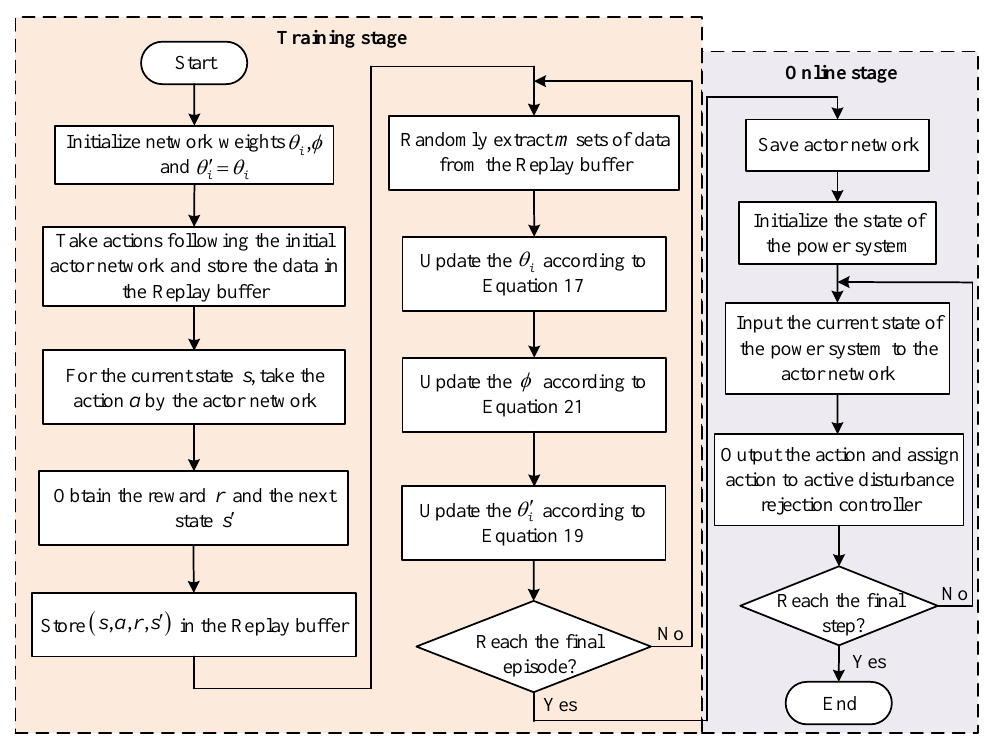
Figure 4. Flowchart of LADRC parameter optimization based on SAC.